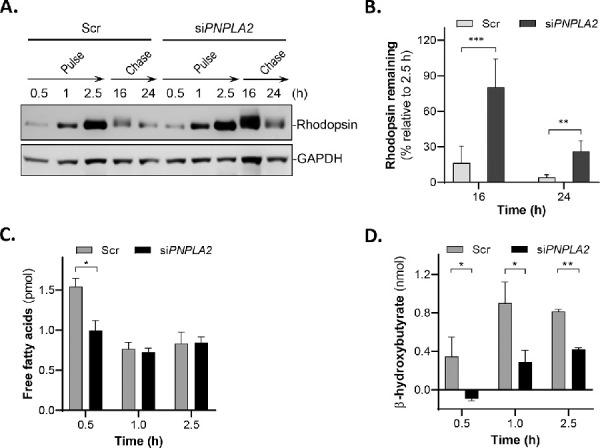
Phagocytosis and fatty acid metabolism in siPNPLA2 cells. ARPE-19 cells were transfected with Scr or siRNAs targeting PNPLA2. At 72 hours after transfection, ARPE-19 cells were incubated with POSs (1 × 107 units/mL) in 24-well tissue culture plates for pulse–chase experiments. (A) Representative immunoblot of total lysates of ARPE-19 cells at 0.5 hour, 1 hour, and 2.5 hours of POS pulse and at 16-hour and 24-hour chase periods, as indicated at the top of the blot. Proteins in cell lysates were subjected to immunoblotting with anti-rhodopsin followed by reprobing with anti-GAPDH as the loading control. (B) Quantification of rhodopsin from duplicate samples and three blots of cell lysates from pulse–chase experiments and time periods (indicated in the x-axis) as from panel. Data are presented as mean ± S.D; **P < 0.01; ns, not significant. Intensities of the immunoreactive bands were determined, and the percentages of the remaining rhodopsin after 16-hour and 24-hour chase periods relative to rhodopsin at 2.5-hour pulse are plotted (y-axis). (C, D) Levels of secreted free fatty acids (C) and β-HB (D) were measured in culture media of cells transfected with Scr or siPNPLA2 following incubation with POS for the indicated periods of times (x-axis). Data are presented as mean ± SD. *P < 0.05, **P < 0.01 (n = 3). Duplex siPNPLA2 C was used to generate the data (see Table 3 for sequences of duplexes).